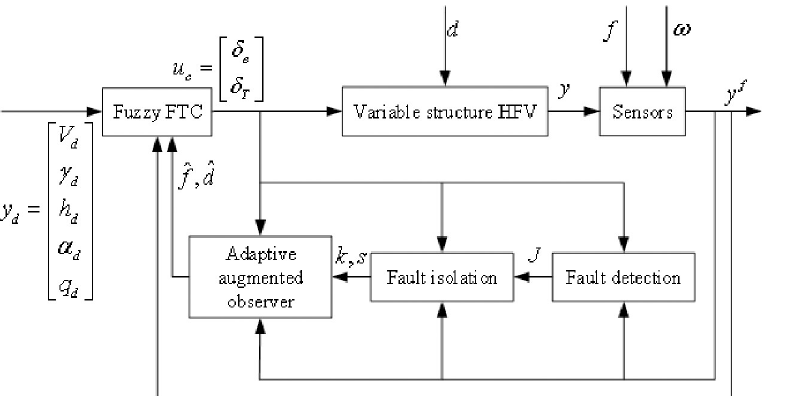
Fig 1. Overall control structure diagram of